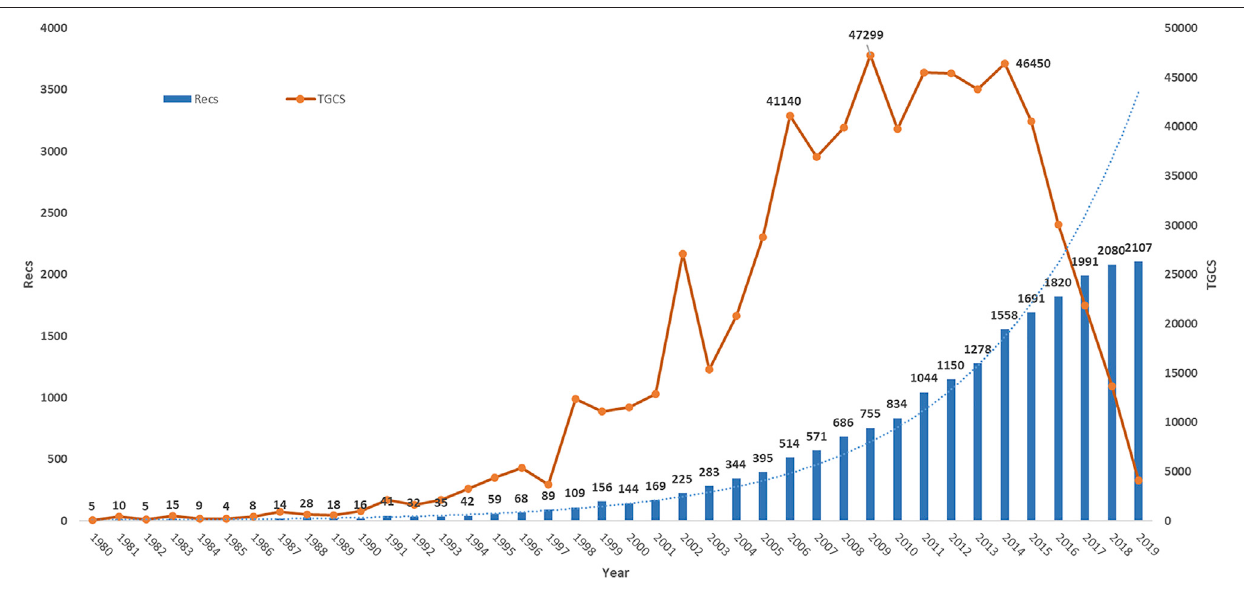
FIGURE 1 | Timeline of publications and TGCS on